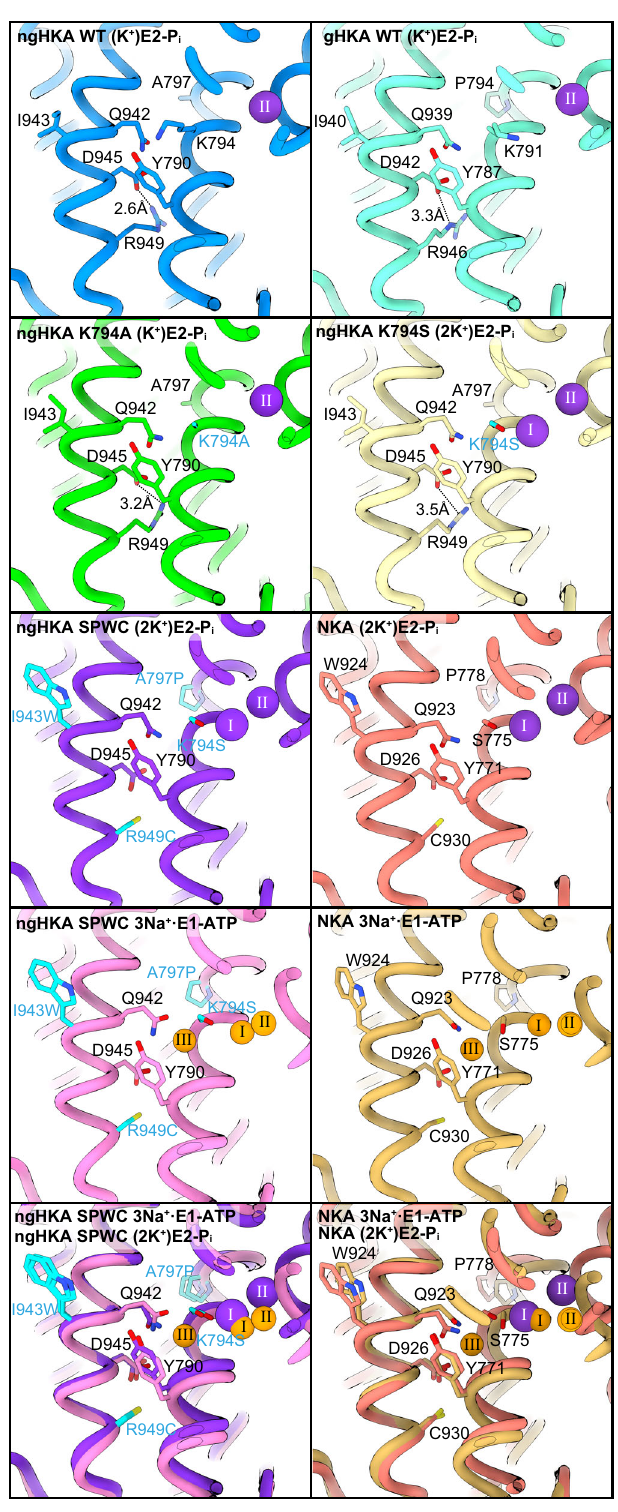
Fig. 9 | A salt bridge between Asp945 and Arg949 of ngHKA. Close-up views of the TM5 and TM8 region where the Na + -binding-site-III-coordinating Asp945 is located in SPWC-ngHKA. The equivalent positions for gHKA and NKA are shown. Asp945formsasaltbridge(dottedlines)withArg949intheE2-P i structuresofWT-, K794A-, and K794S-ngHKA. This salt bridge is also observed in gHKA structures, whileobviouslyabsentinSPWC-ngHKAandNKA,duetothereplacementofArg949 with Cys. Comparison of 3Na + ·E1-ATP and (2K + )E2-P i state of SPWC-ngHKA and its equivalent states for NKA (bottom panels) show little displacement in this site-III region during the transport